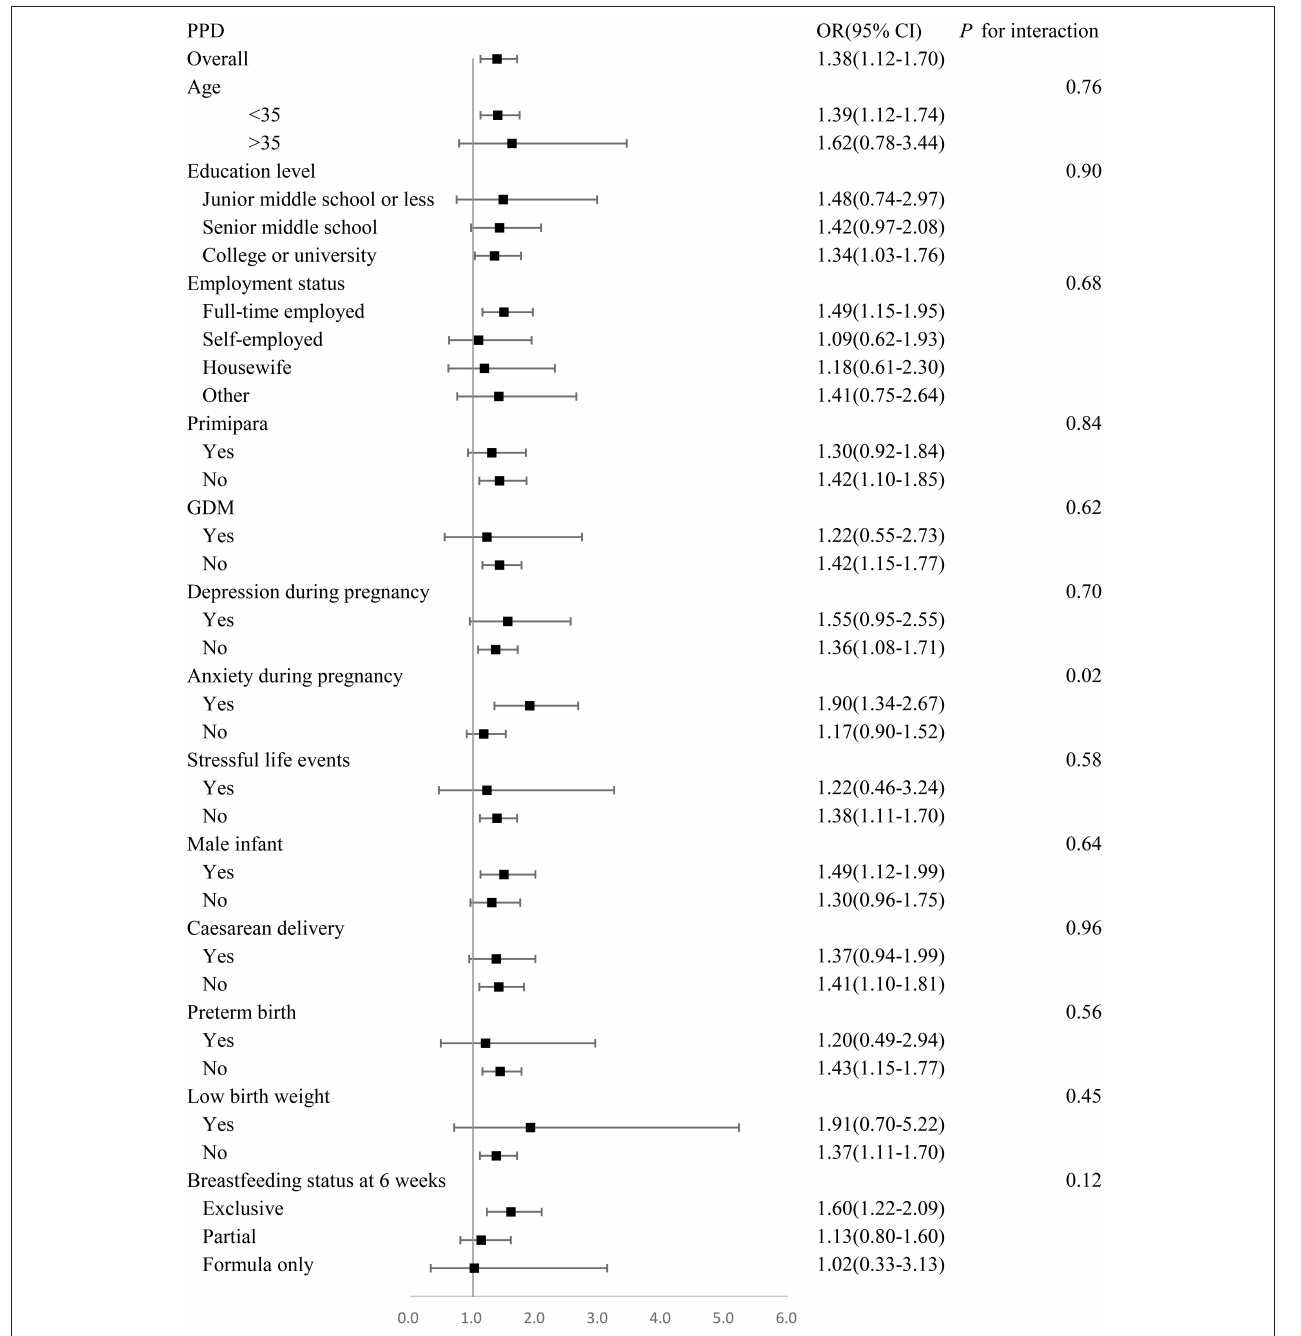
FIGURE 2 | Adjusted odds ratios for prevalence of PPD stratified by age, education, employment, parity, GDM, depression during pregnancy, anxiety during pregnancy, stressful life events, infant gender, mode of delivery, preterm birth, low birth weight, feeding method at 6 weeks. Analyses are adjusted for age, education, employment, past psychiatric history, family history of mental illness, parity, GDM, PIH, depression during pregnancy, anxiety during pregnancy, stressful life events, infant gender, mode of delivery, preterm birth, low birth weight, malformation, feeding method at 6